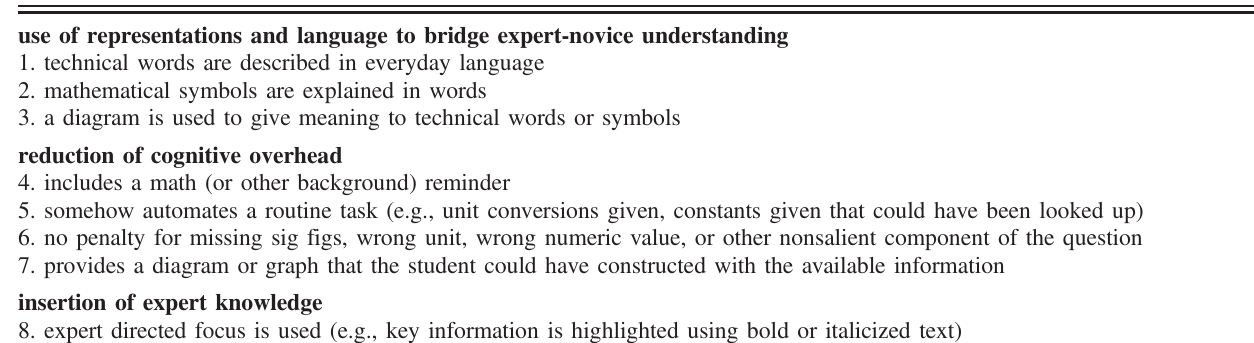
TABLE III. The 6 elements of scaffolding (bold), with itemized examples of how each element is likely to appear in written physics